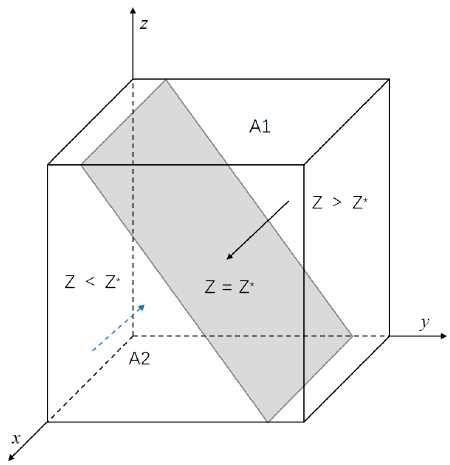
Figure 2. Phase diagram for strategy evolution of the construction enterprise.